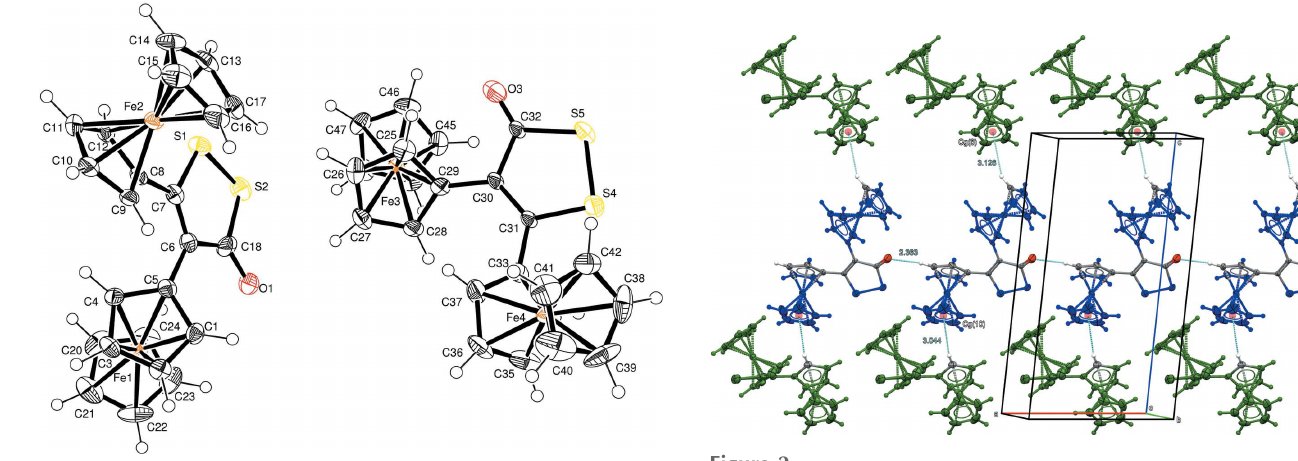
(8) along the a 1